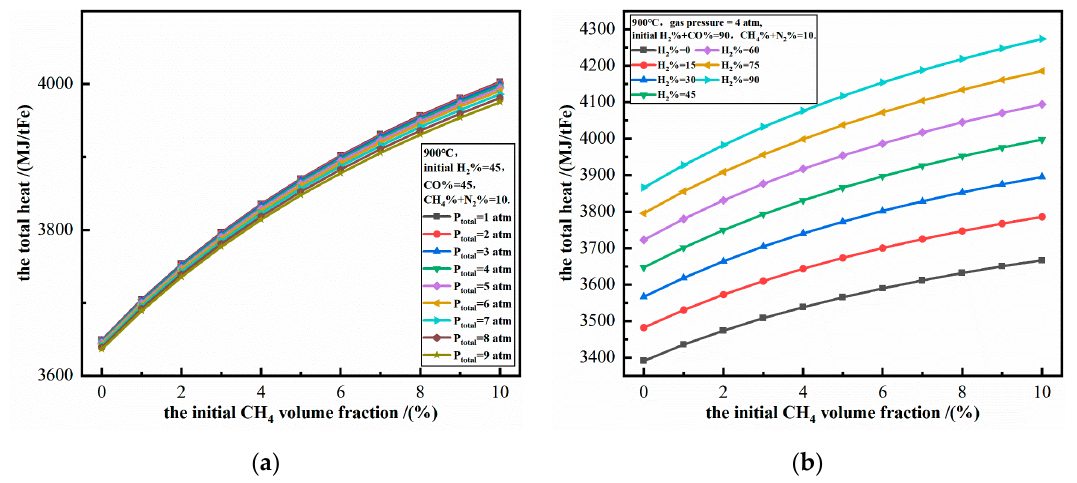
Figure 14. The relationship between the total heat and the initial CH 4 volume fraction at 900 °C. ( a ) H 2 % = 45, CO% = 45, total pressure is 1–9 atm; ( b ) H 2 % + CO% = 90, total pressure is 4 atm.